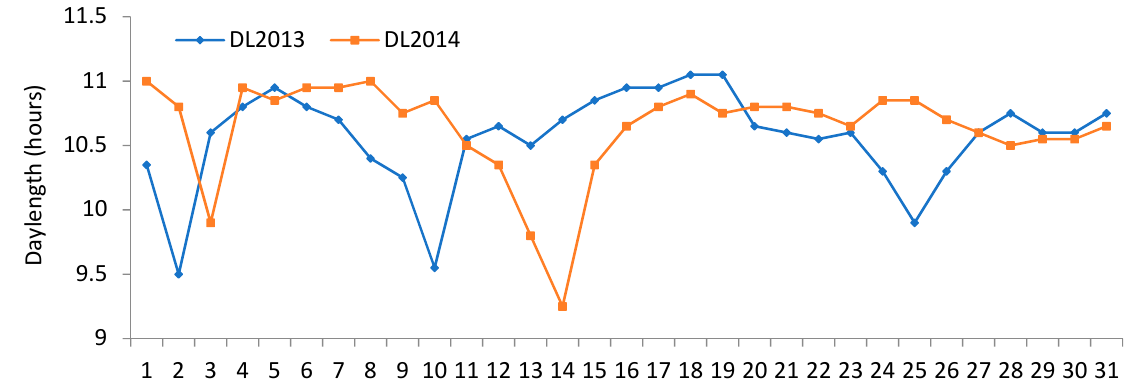
Figure 8. Daylength variation during the flowering window in December for Chadian dry-season sorghum sown at the Youé research farms, Chad, in 2013 and 2014.